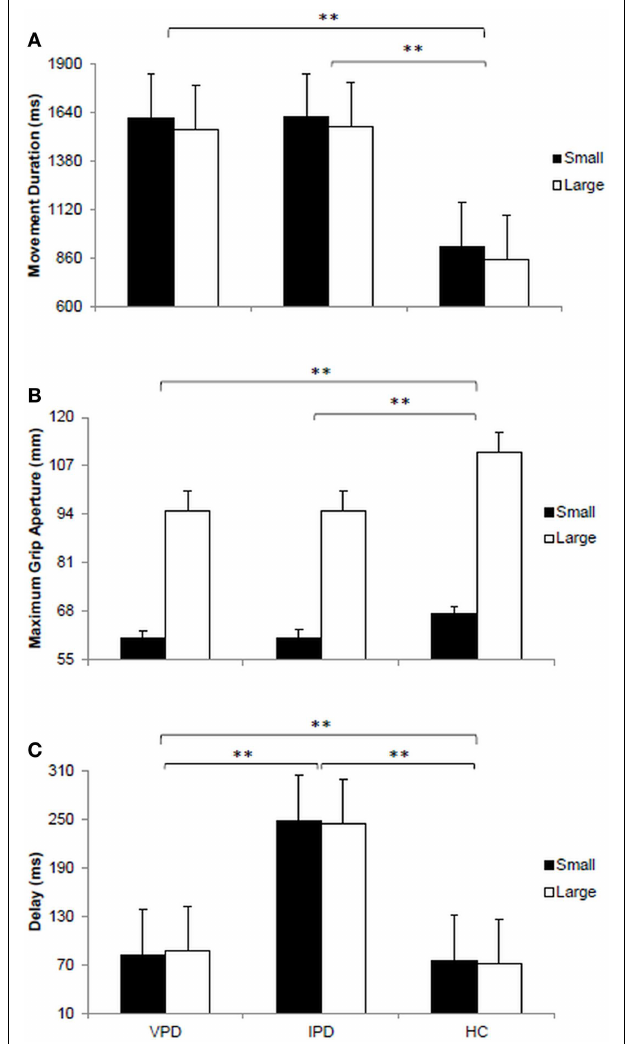
FIGURE 2 |Visual presentation of the dependent variables measured for each of the groups tested . (A) Bar plot represents the movement duration expressed in milliseconds (ms). (B) Bar plot shows the maximum grip aperture measured in millimeters (mm). (C) Bar plot demonstrates the delay between the beginning of the arm movement towards the target object and the opening of the fingers to grasp it.VPD, vascular parkinsonism; IPD, idiopathic Parkinson’s disease; HC, healthy